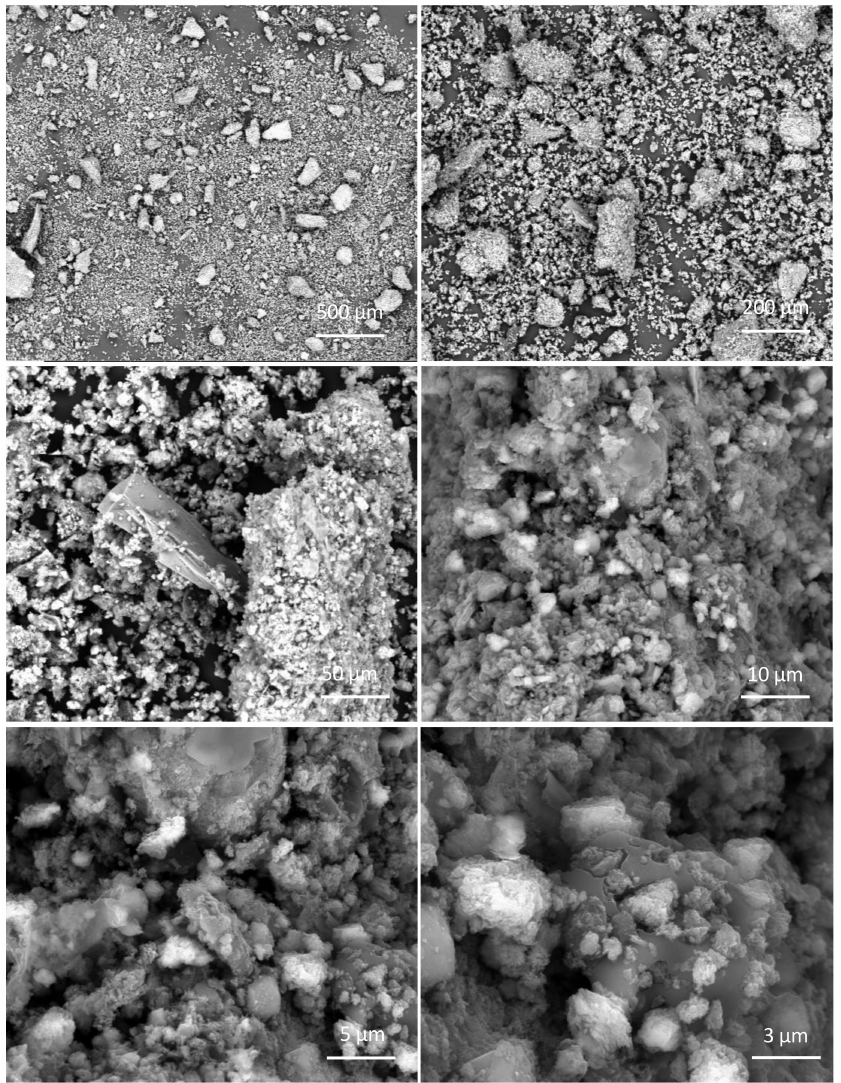
Figure 5. Scanning electron micrographs of biomass at different magnification